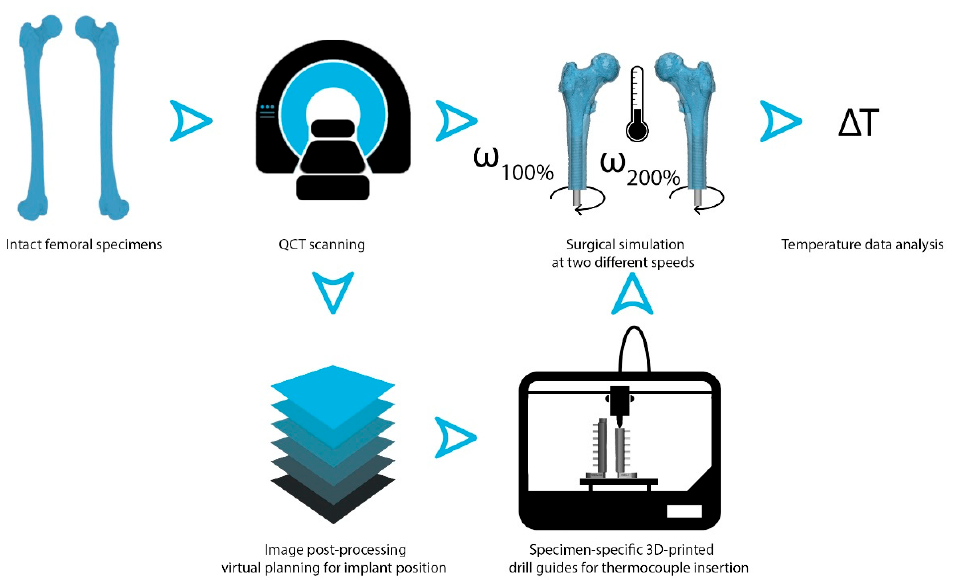
Figure 1. Graphical abstract of the project: Twenty-four paired femoral specimens were scanned using a QCT scanner. Images were postprocessed to create specimen-specific drill guides to facilitate the placement of thermocouples in each specimen. The surgery was performed at the clinically practiced speed ( ω 100% ) in one femur of each pair and at the doubled speed in the contralateral specimen ( ω 200%) . Consequently, data analysis was performed to assess if the higher speed generates more heat.